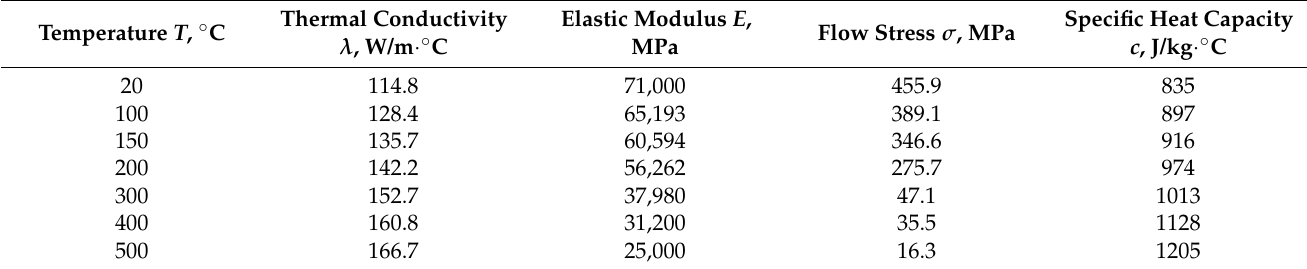
Table 1. Parameters of 7050 aluminum alloy.